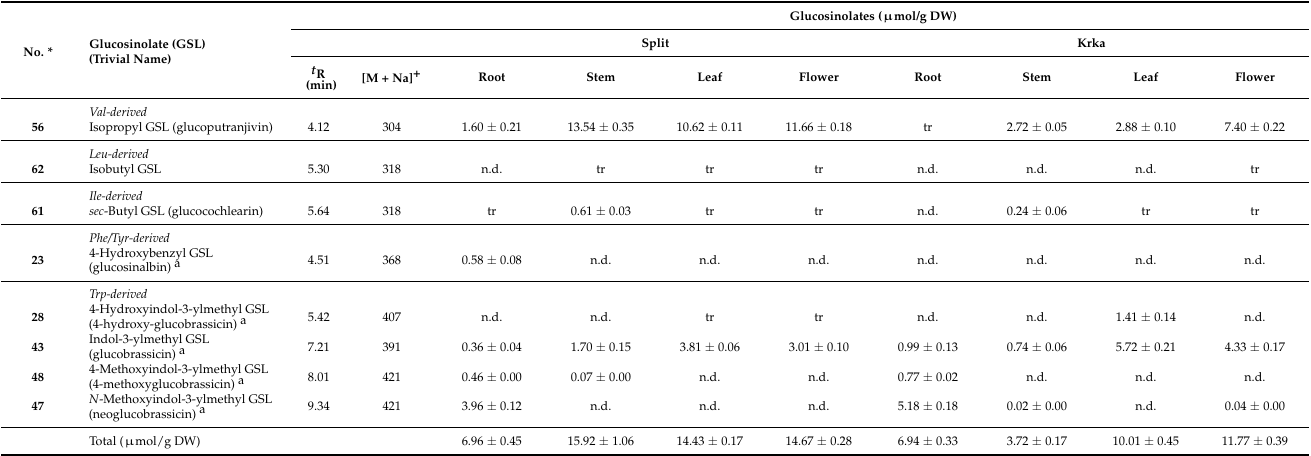
Table 1. Glucosinolate (GSL) content in diverse Sisymbrium officinale plant parts collected from different locations.